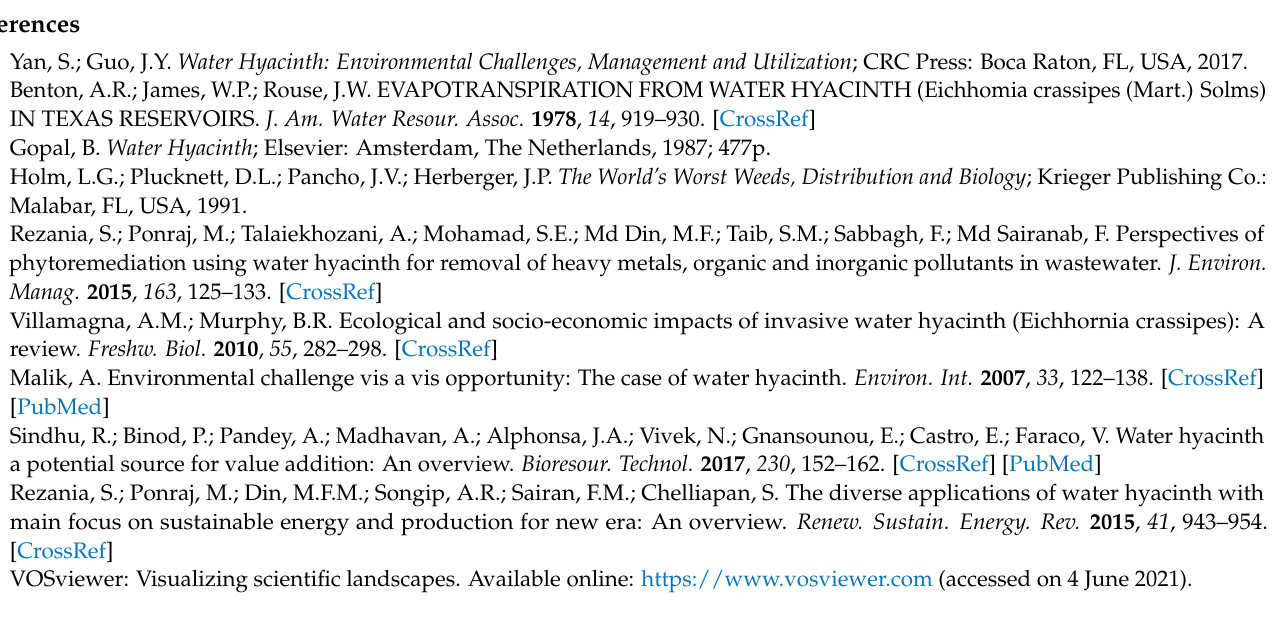
Table S2: Top 10 cited documents of the growth period (2001–2014), Table S3: Top 10 cited documents of the growth period